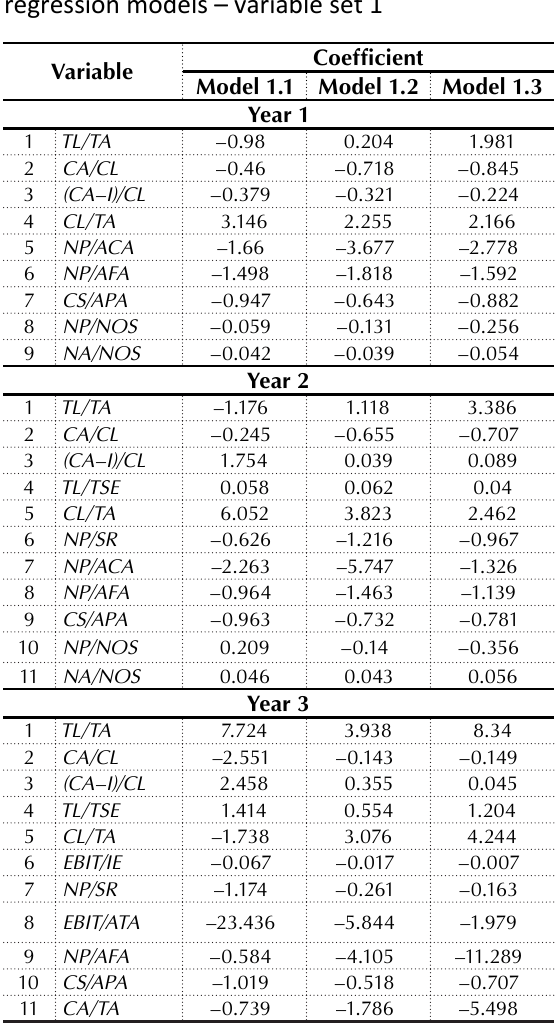
Table 2. Stepwise selection results for logistic